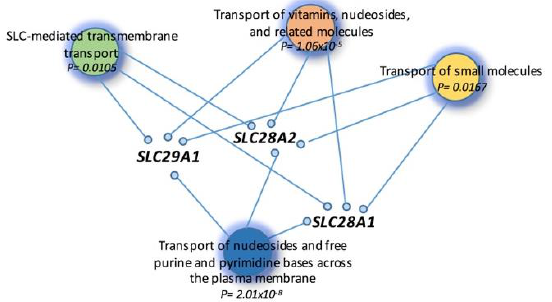
Figure 2. Inter-connection of metabolic pathways for the eight identified genes. Pathway enrichment analysis highlights four pathways in which the investigated genes are mainly involved. P: p -value.